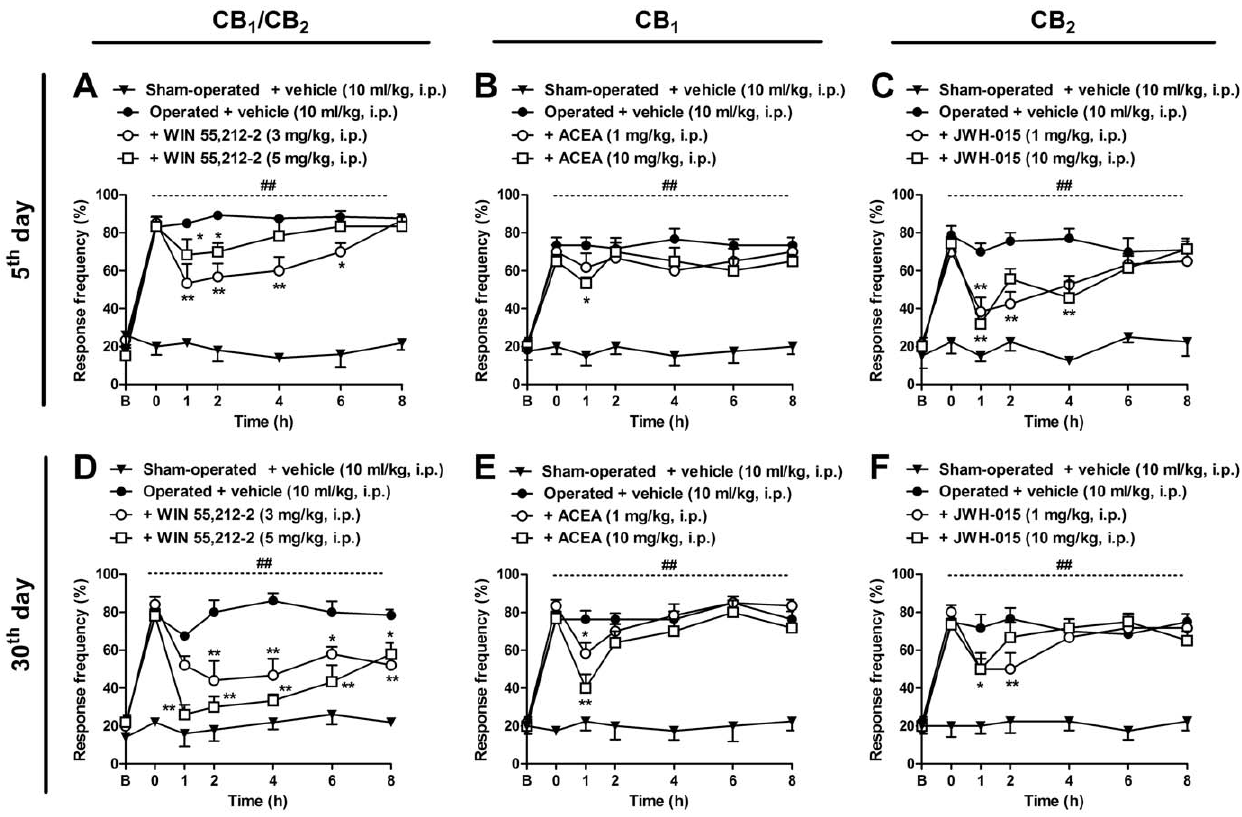
Figure 5. Systemic administration of cannabinoid agonists inhibits mechanical allodynia induced by brachial plexus avulsion (BPA) in mice. Response frequency of the right hindpaw assessed at several time-points in sham-operated and operated (BPA) mice treated with the non- selective CB 1 and CB 2 agonist, WIN 55,212-2 (3–5 mg/kg, i.p.), the selective CB 1 agonist, ACEA (1–10 mg/kg, i.p.), the selective CB 2 agonist, JWH-015 (1–10 mg/kg, i.p.) or vehicle (10 ml/kg, i.p.), administered on the 5 th (A, B and C) or 30 th (D, E and F) day after surgery. Data are expressed as mean 6 SEM (n=4–6/group). *p , 0.05 and **p , 0.01, significantly different from the operated group treated with vehicle (two-way ANOVA with Bonferroni’s post hoc test). B, Baseline withdrawal threshold before surgery. 0, baseline withdrawal threshold after surgery on the day of the experiment (5 th and 30 th days).